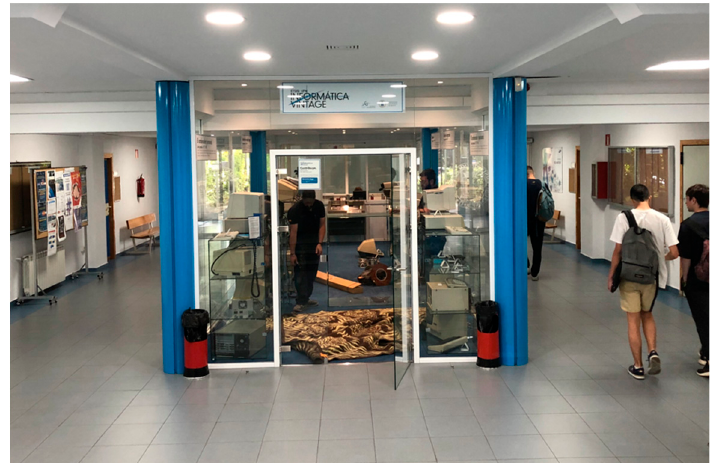
Figure 3 . Informática Vintage Museum (ETSISI – UPM).